Question: Briefly state, in one sentence, what is plotted here.
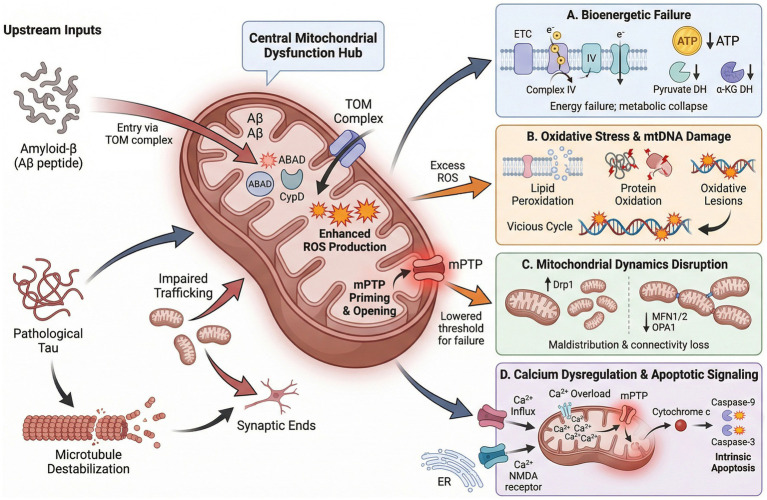
Answer: Central role of mitochondrial dysfunction in Alzheimer’s disease. (A) Bioenergetic failure. Aβ-mediated mitochondrial impairment reduces electron transport chain activity and key tricarboxylic acid cycle enzymes, leading to ATP depletion and metabolic stress. (B) Oxidative stress and mtDNA damage. Defective respiration increases reactive oxygen species production, driving oxidative damage and mitochondrial DNA instability. (C) Mitochondrial dynamics disruption. Enhanced fission and reduced fusion promote mitochondrial fragmentation, impairing organelle distribution and connectivity. (D) Calcium dysregulation and apoptosis. Mitochondrial calcium overload triggers mPTP opening, cytochrome c release, and activation of intrinsic apoptotic signaling.